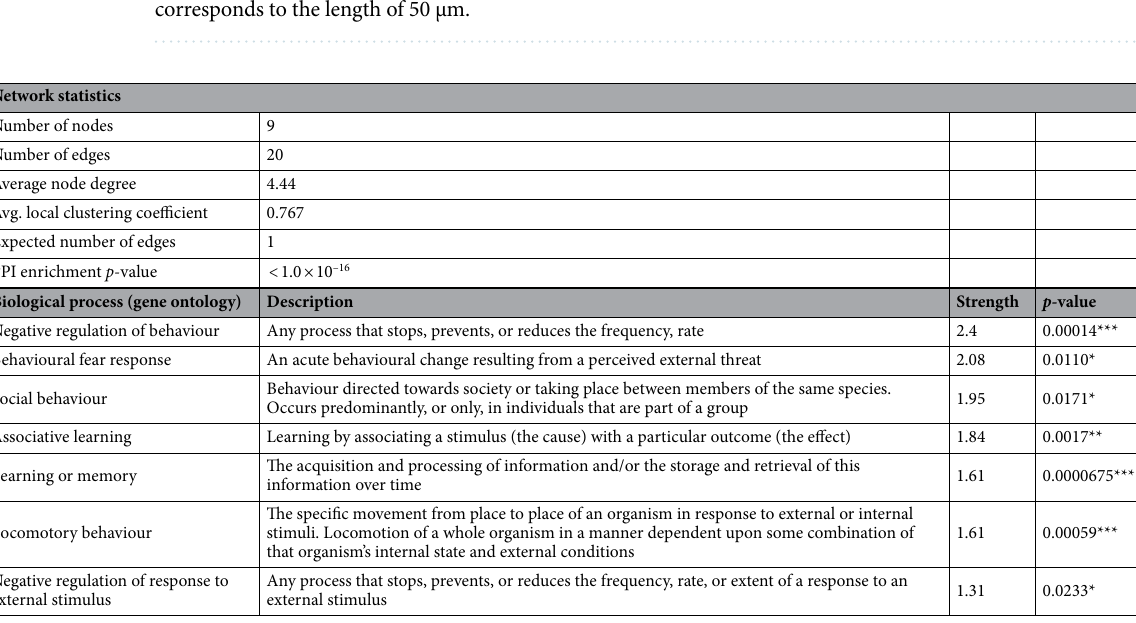
Table 2. Network statistics and biological process (Gene Ontology) of the interactions. *( p ≤ 0.05), **( p ≤ 0.01) and ***( p ≤ 0.001) indicates statistically